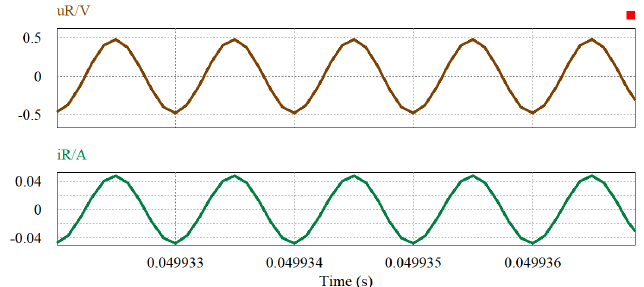
Figure 13. Simulation waveforms of FO-WPT.